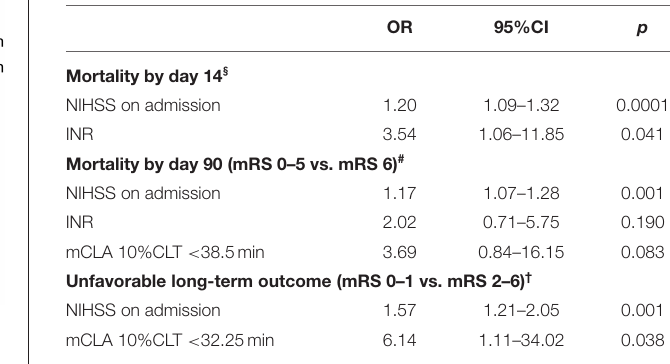
TABLE 5 | Independent predictors of outcomes in the studied